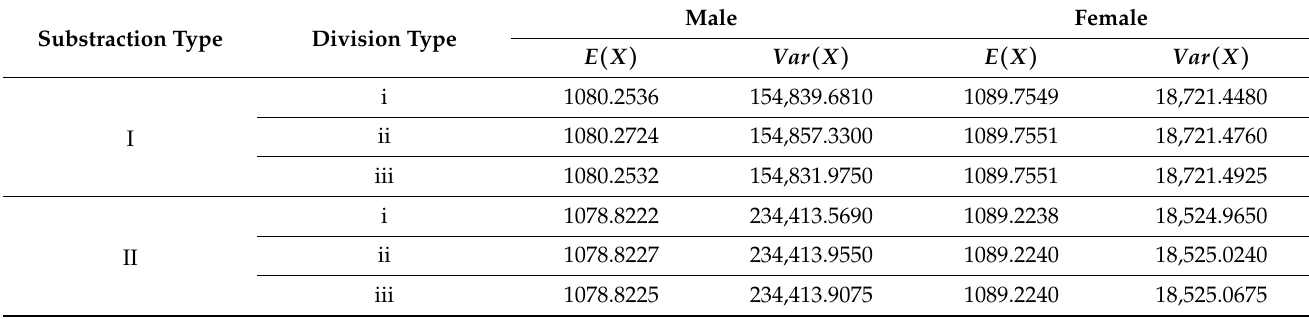
Table A12. The expectations and variances of EHL distributions obtained by MLEs in Table